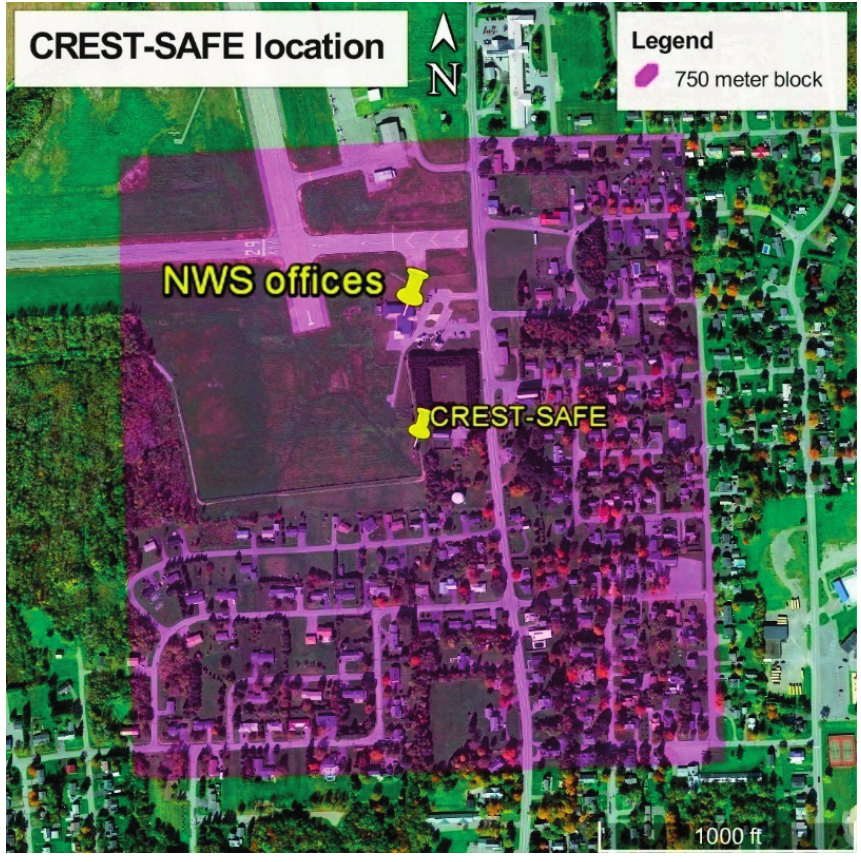
Figure 5 . CREST-SAFE land cover 750-m block